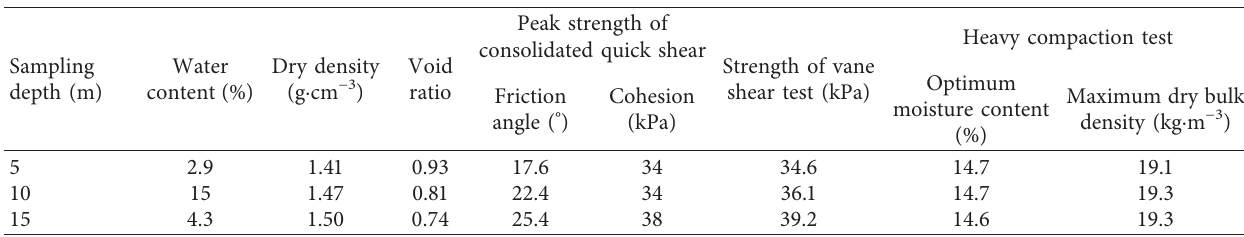
Table 1: Subsoil main properties.